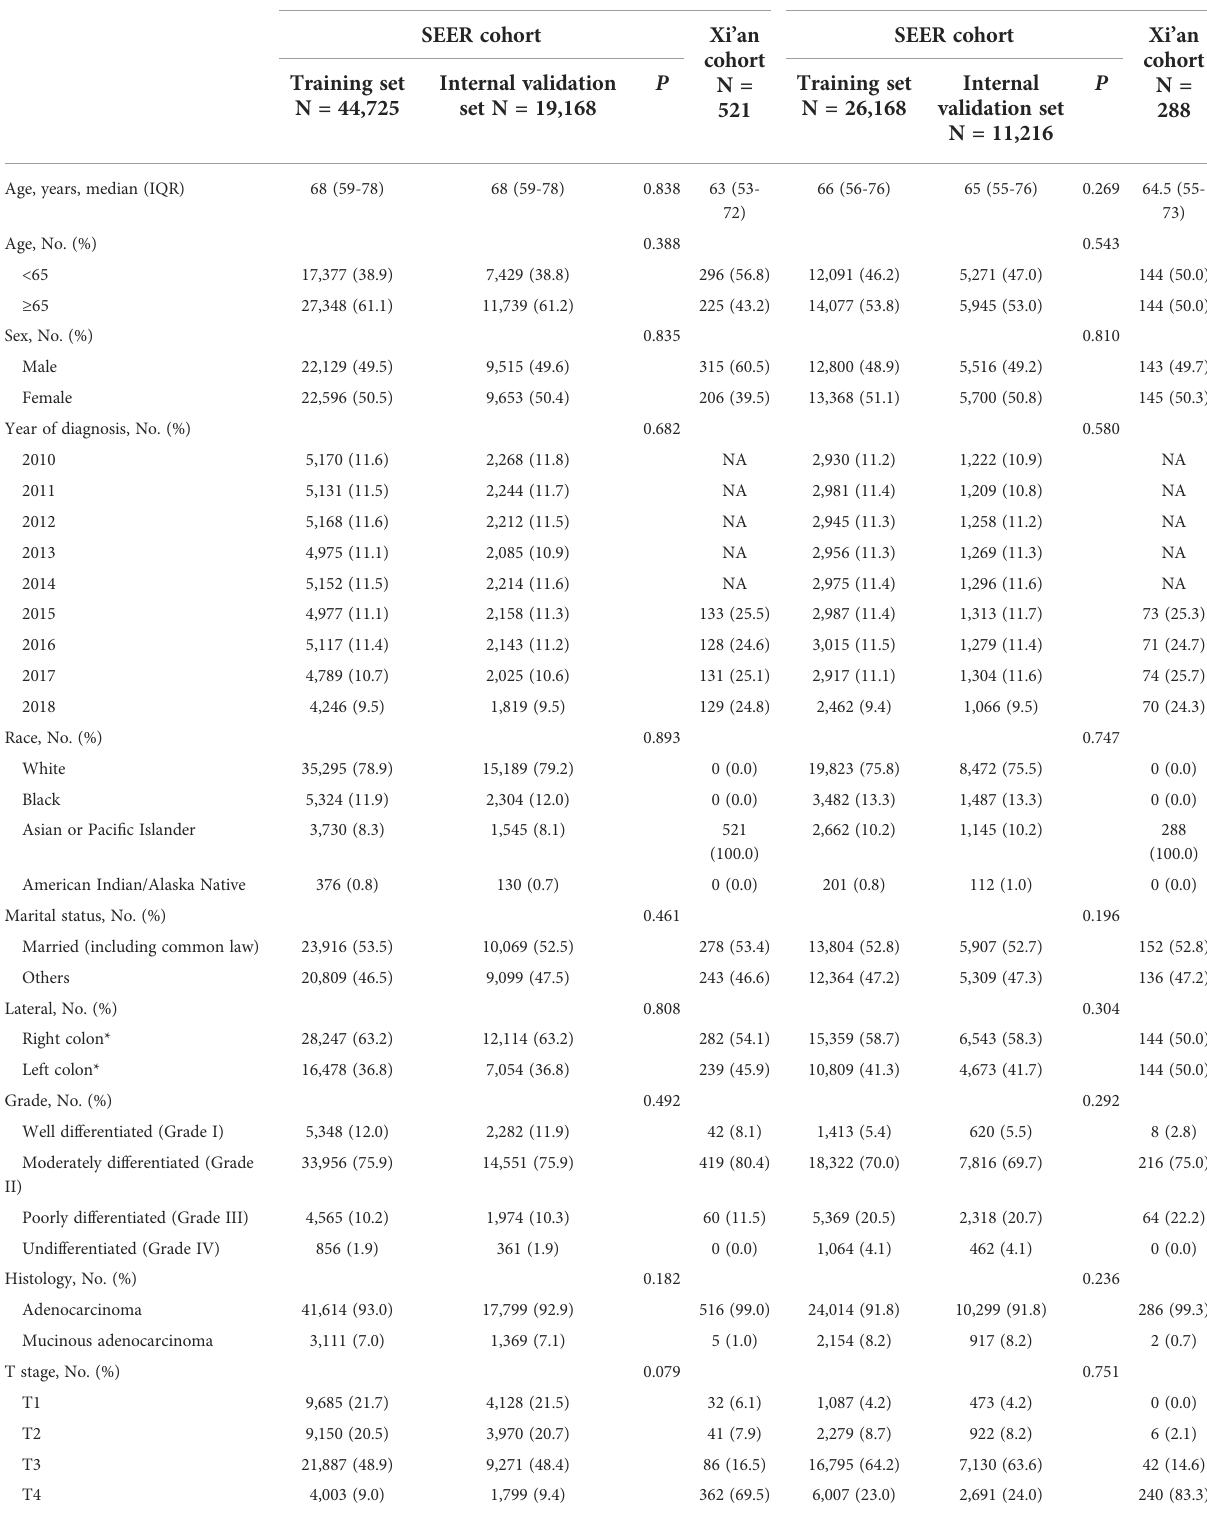
TABLE 1 Baseline characteristics of patients with colon cancer in the training, internal validation and external validation data sets. Variables Stage I/II Stage III SEER cohort Xi ’ an SEER